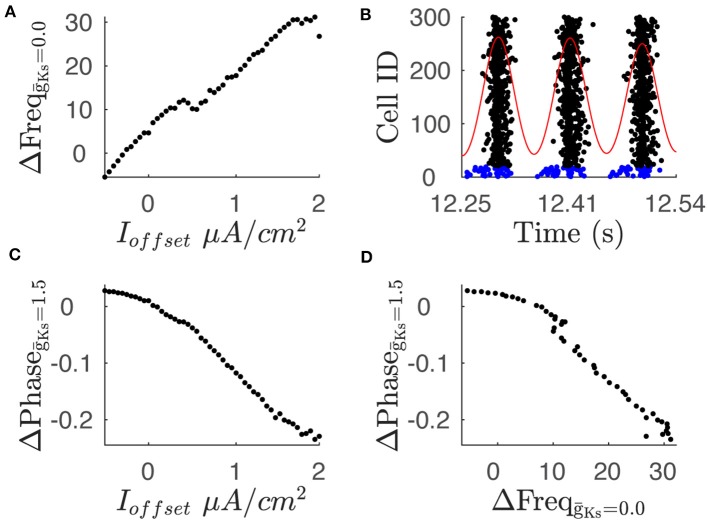
Variations in current input between neuron subsets leads to changes in average frequency and phase. (A) The difference in average frequency of the two neuron populations shows a positive relationship with the difference in current input, labeled as Ioffset, when g¯Ks is 0.0. (B) Raster plot shows phase leading in spike times of neuron subset. The raster plot shows spike times for neuron population where 20 neurons receive an additional current input of 1.95 μA/cm2. Blue rasters indicate subpopulation with additional current while black rasters indicate sub population with baseline current input. Red trace shows convolution of spike times with Gaussian function which is used to define the phase reference. The above simulation is conducted with a g¯Ks value of 1.5. (C) Phase difference between subpopulation with additional current input and subpopulation with baseline current input shows a negative relationship with the current input. (D) Comparison of the phase difference and frequency difference for a given current input. Plot shows comparison of phase difference for g¯Ks = 1.5 and frequency difference for g¯Ks  = 0.0 for a given current offset.